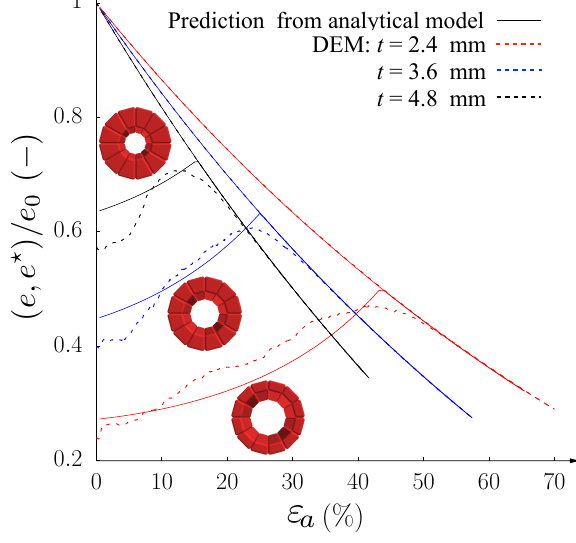
Figure 5. Normalised evolution of void ratio e / e 0 and its redef- inition e ? / e 0 . DEM curves (dashed lines) and predictions (solid lines), Eq. (6), for clusters with various pore sizes, achieved by through shell thickness t with constant external diameter d . Linearity of breakage level was adjusted as follows: b = 0 . 024 " a (red), b = 0 . 04 " a (blue), and b = 0 . 065 " a